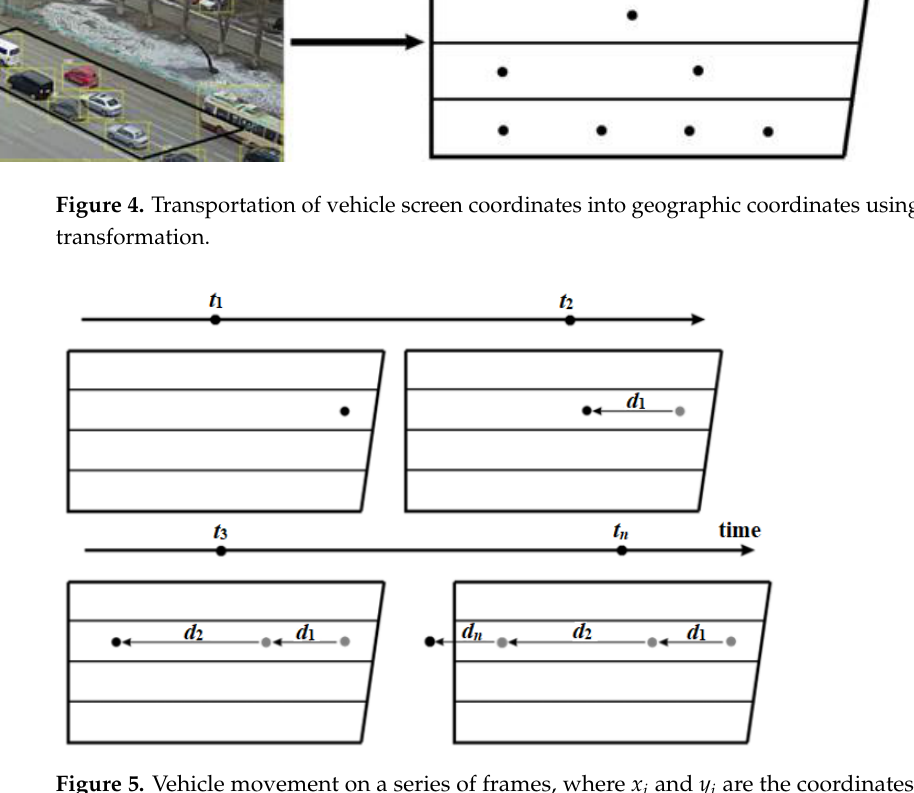
Figure 5. Vehicle movement on a series of frames, where x i and y i are the coordinates of a specific vehicle; d i is the distance between two points; and t i is the time between frames.